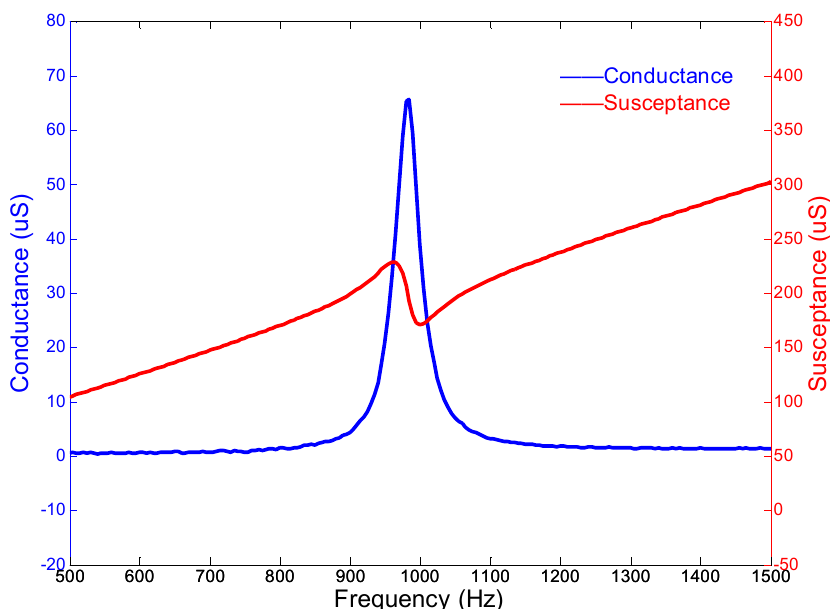
Figure 12. Admittance curves of cascade-connected transducers with twelve segments (obtained from Agilent 4294A).